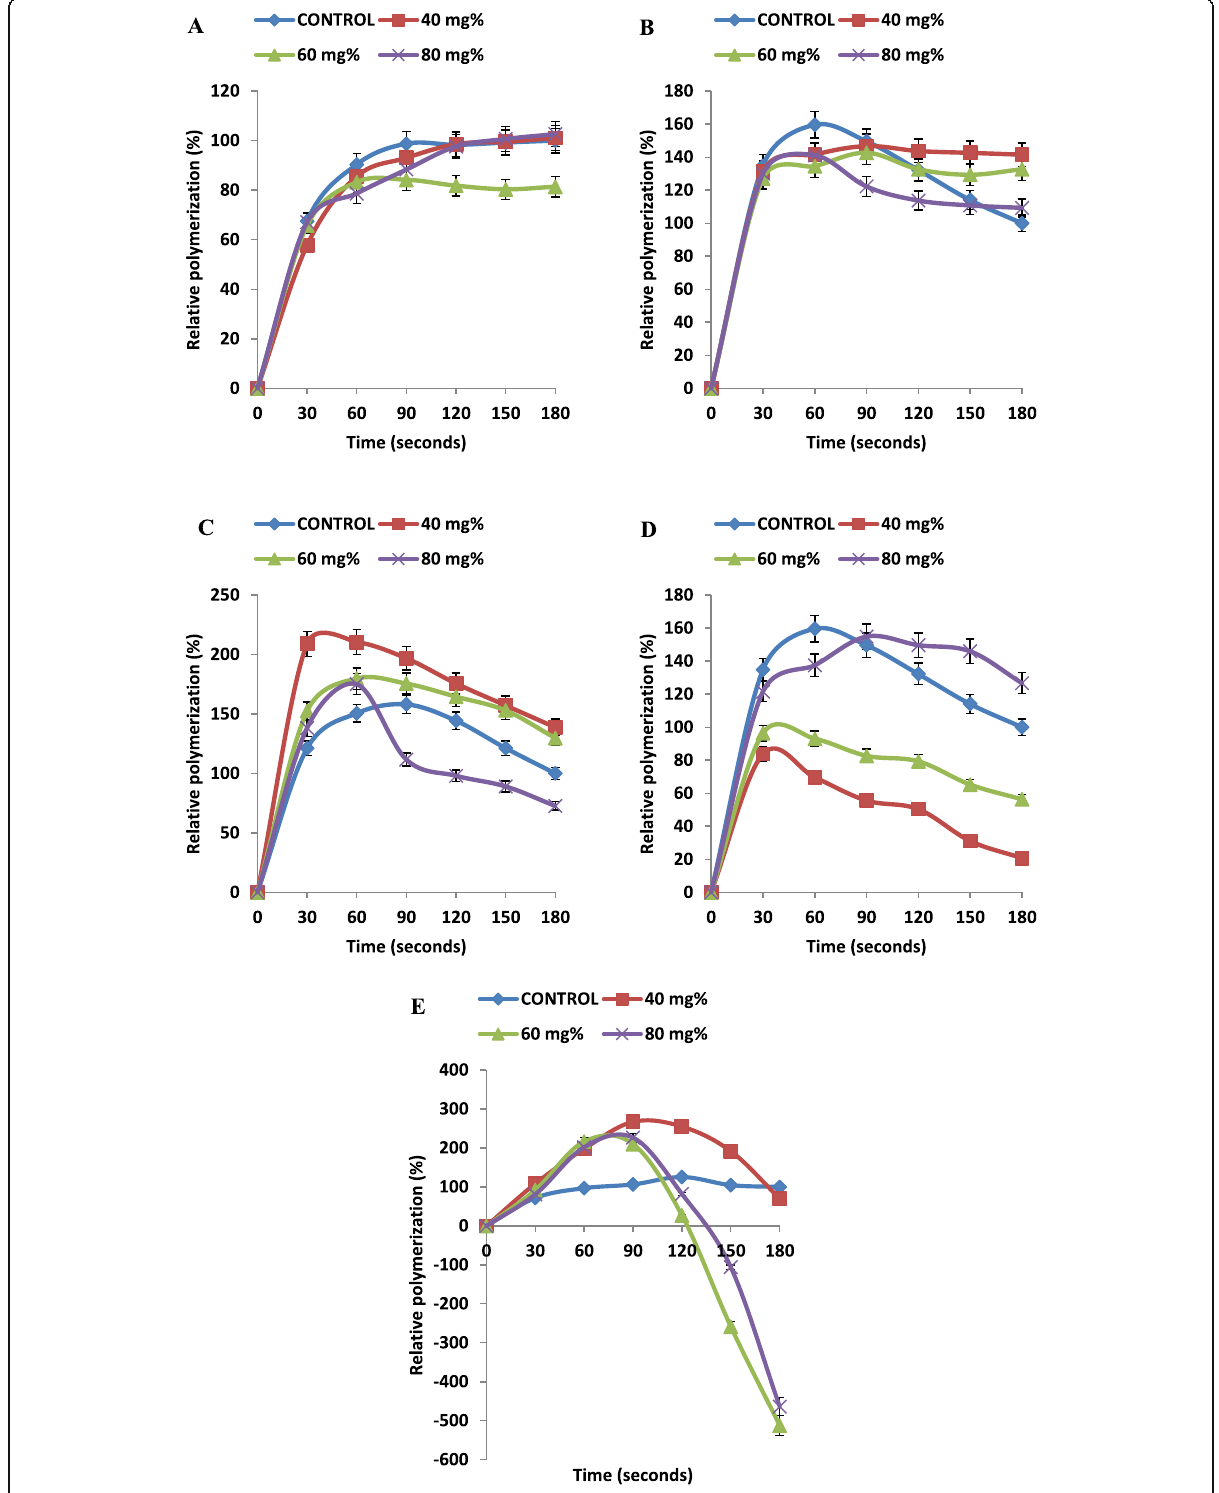
Fig. 1 Comparative levels of poly-dHbS-M of control sample and in the presence of fractionated leaf extracts of A . occidentale. a Petroleum ether. b n -hexane. c Chloroform. d Ethylacetate. e Residual aqueous; mg% = mg/100